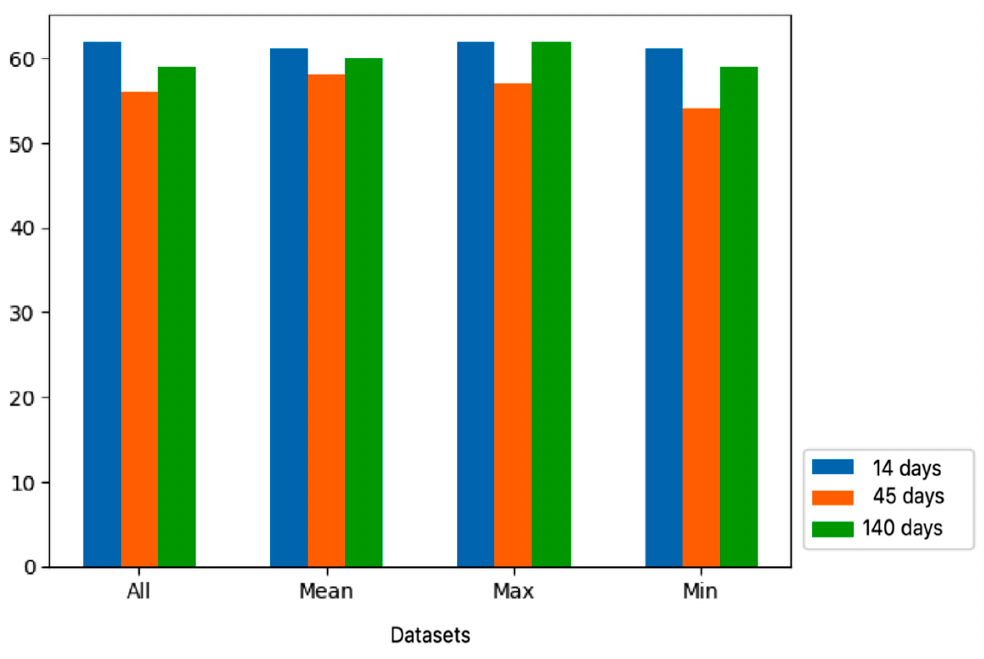
Figure 10. Accuracy vs. clustering thresholds.